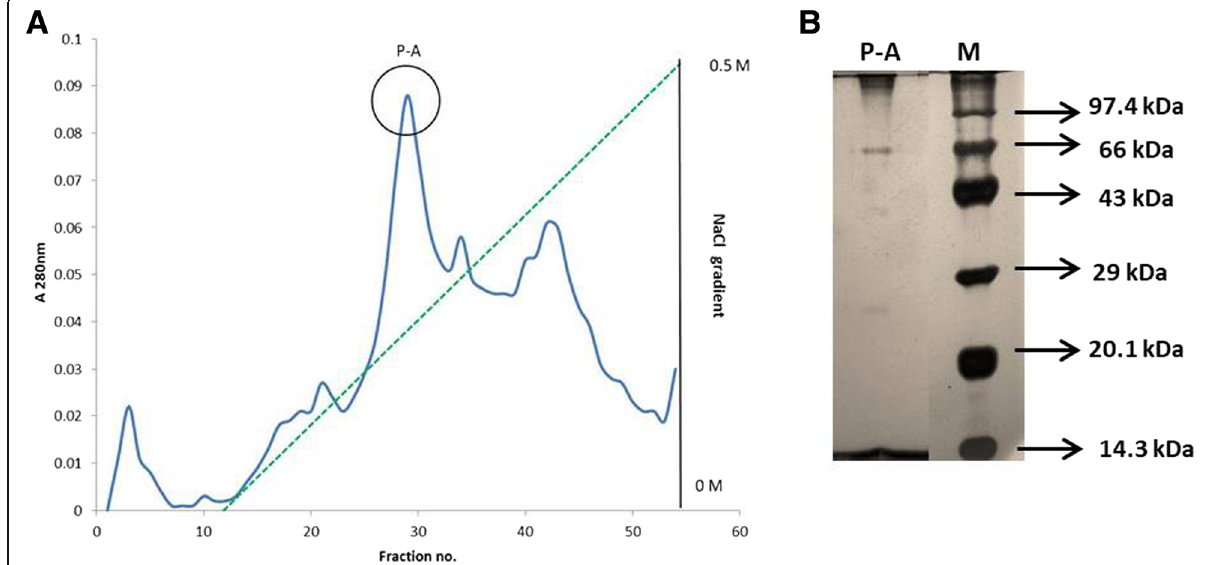
Fig. 1 Fractionation of SCF using DEAE Sephadex A-25 column (5 ml) and estimation of protein purity: SCF was fractionated using anion- exchange chromatography on DEAE Sephadex A-25 column. Mobile phase was 50 mM KPB, pH 7.4. One major peak was eluted using a gradient of sodium chloride ( A ). This protein peak was designated as P-A and studied further. Protein peak P-A showed three major protein bands as seen in SDS-PAGE gel followed by silver staining ( B